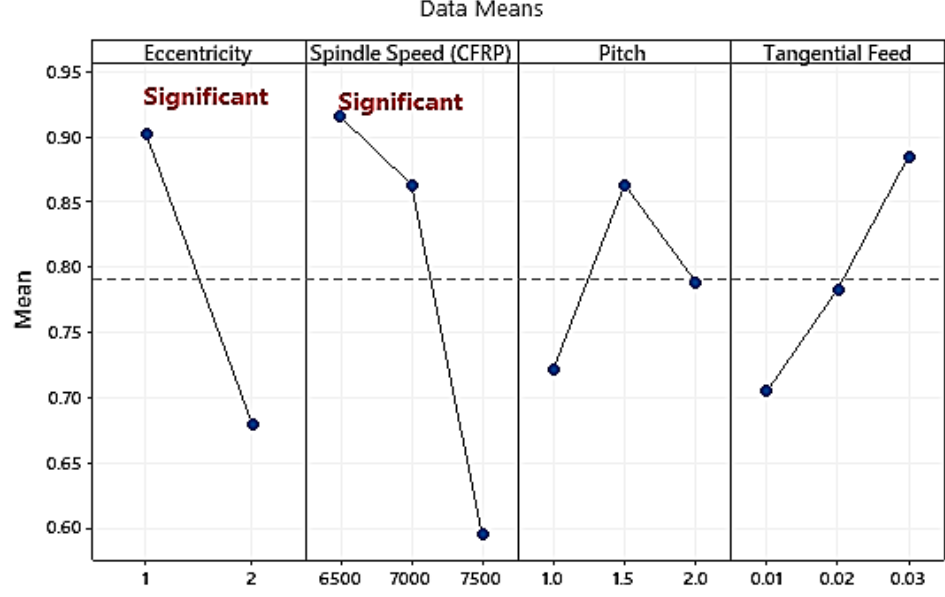
Figure 9. Main effects plot of average surface roughness of CFRP.